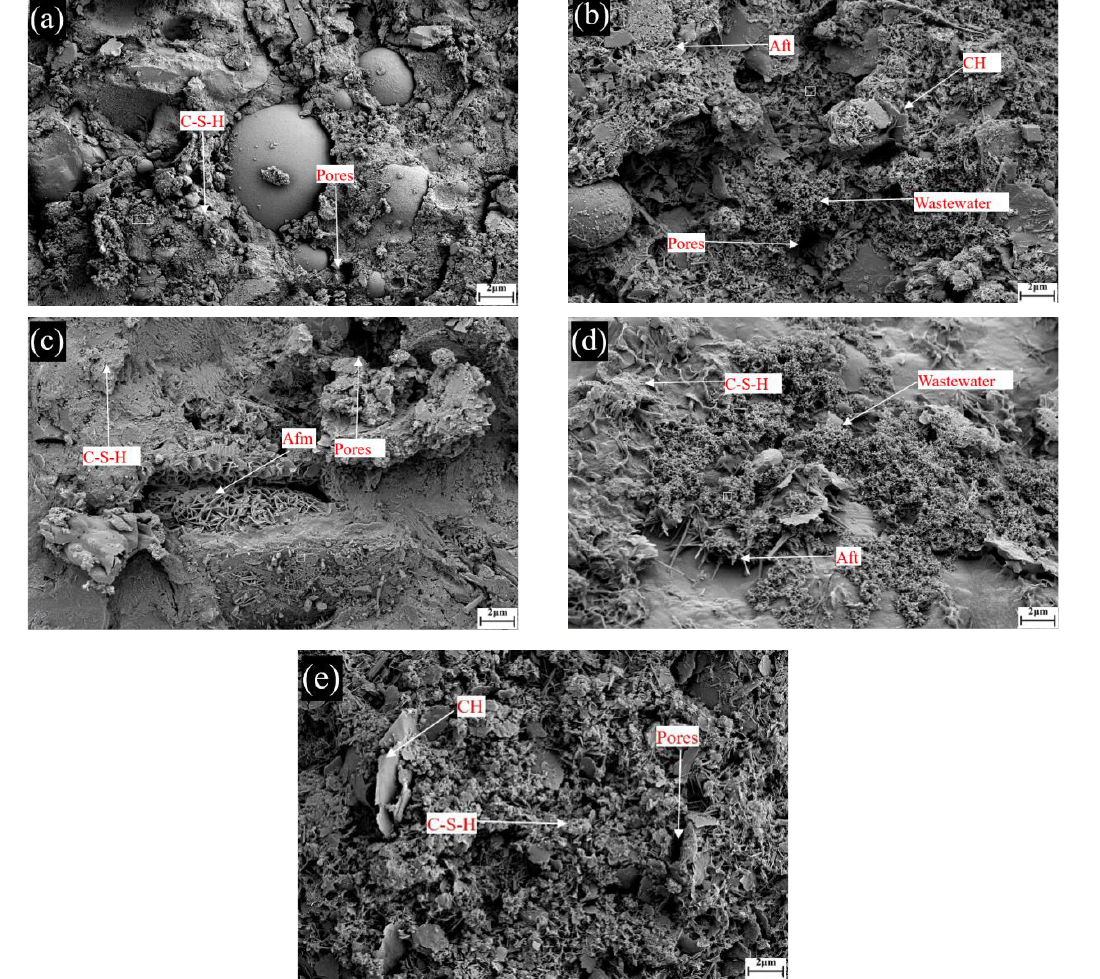
Figure 9. SEM image of C20 concrete at the age of 28 days. ( a ): C20-0, ( b ): C20-25, ( c ): C20-50, ( d ): C20-75, ( e ): C20-100. Aft = ettringite, Afm = monosulfur hydrated calcium sulphoaluminate, C-S-H = calcium silicate hydrate, CH = Ca(OH) 2 , CC = CaCO 3 .